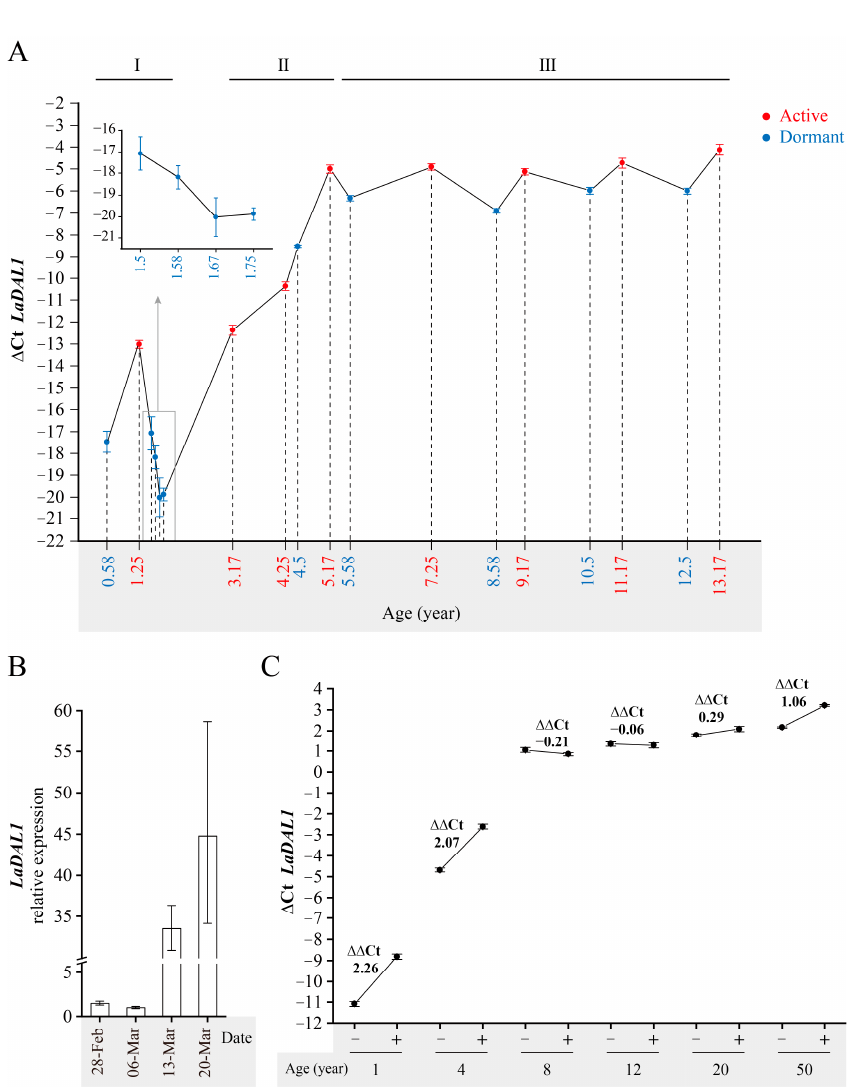
Figure 2. Regulation of LaDAL1 by age and seasonal environmental signals. ( A ) Expression pattern of LaDAL1 in the annual growth cycle of Larix kaempferi trees of different ages. The main stems or lateral branches from the upper crowns were collected. When sampling, the buds and needles were removed, and the left stems were used for RNA extraction. The tree age was accurately calculated when appropriate. The materials sampled in the active phase are shown by the red color and those sampled in the dormant phase are shown by the blue color, and the detailed sample information was given in the Supplemental Table S2. The LaDAL1 expression patterns were assayed by qRT- PCR with L. kaempferi translation elongation factor-1 alpha 1 ( LaEF1A1 ) as the internal reference gene. ( B ) Expression pattern of LaDAL1 during reactivation naturally induced by spring temperature. The main stems of dormant L . kaempferi trees grown from seeds planted in April 2018 were sampled in early spring of 2019. When sampling, the buds were removed. The LaDAL1 expression patterns were assayed by qRT-PCR with L. kaempferi ubiquitin-conjugating enzyme E2 28 ( LaUBC1 ) as the internal reference gene. ( C ) Variation of LaDAL1 transcript levels in dormant L . kaempferi cuttings after water culture. Branches from 1-, 4-, 8-, 12-, 20- and 50-year-old dormant trees were harvested on 10 March 2013 and then taken to the laboratory for water culture. In each age category, at least 8 branches were sampled as the intact control (“ − ”), and at least 7 branches were cultured. Following removal of all buds, lanolin was spread over the excised tops of the cuttings and cultured in water with a 16 h photoperiod at 25/20 ◦ C (day/night) and a relative humidity of 75%. Cuttings were sampled after one week (“+”). The LaDAL1 expression patterns were assayed by qRT-PCR with LaEF1A1 and L. kaempferi zinc finger protein ( LaZFP ) as dual internal reference genes. Error bars represent